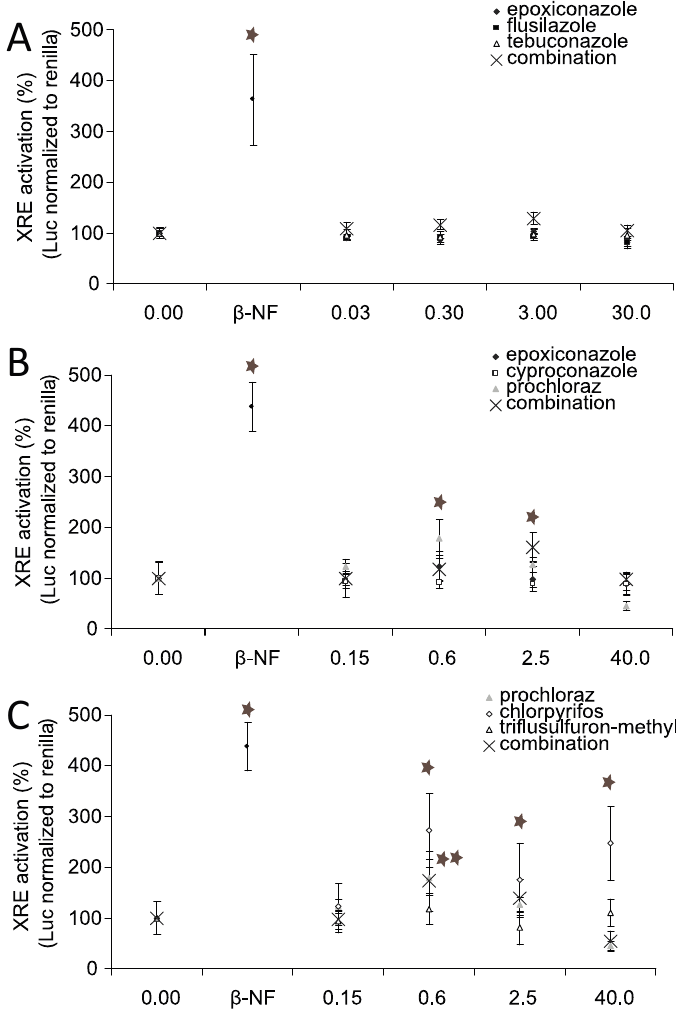
The combination of prochloraz, chlorpyrifos and triflusulfuron-methyl, the latter having had no activation capacity, showed cumulative patterns with a peak at 0.6 µM and 2.5 µM (160% of control at While cyproconazole and epoxiconazole showed no activation properties, the combination, which contained 1/3 of prochloraz, peaked at 2.5 µM (160% of control; p ≤ 0.05) and showed a decrease in effect at higher concentrations. Flusilazole and tebuconazole, like epoxiconazole, were not able